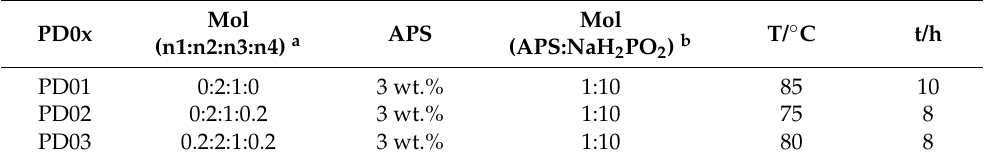
Table 1. Synthesis conditions of dispersants